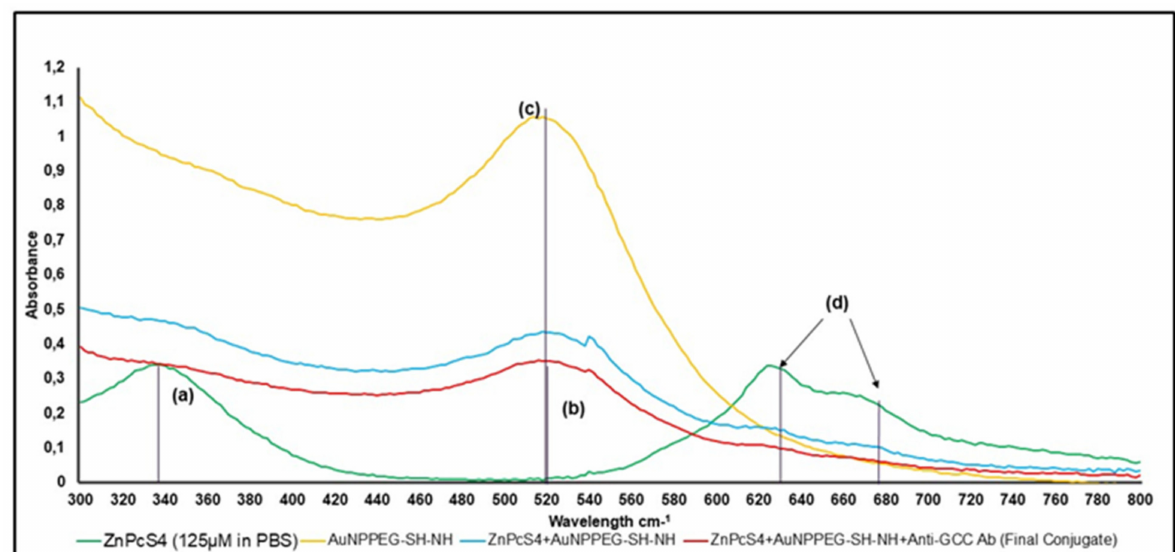
Figure 3. UV visible spectral analysis of BNC and various controls within the 400 to 800 nm visible spectral region. ( a ) PDD ZnPcS 4 340 nm 125 µ m in PBS, whereas final conjugate ZnPcS 4 final concentration remained at 125 µ m, ( b ) final conjugate 520 nm 0.95 × 10 15 AuNP particles/mL (2.99-fold fall), ( c ) AuNP-S-PEG5000-NH 2 520 nm 2.85 × 10 15 particles/mL, and ( d ) PDT ZnPcS 4 634 and 674 nm 125 µ m in PBS, whereas final conjugate is 35 µ M ZnPcS 4 concentration (3.54-fold